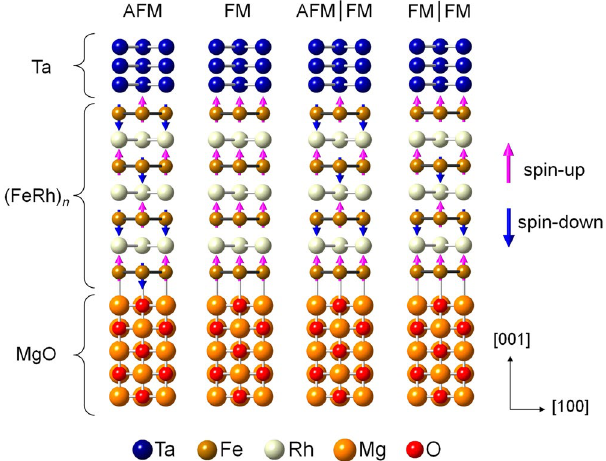
Figure 1. Representation of the atomic structure of Ta/FeRh/MgO multilayers for the different magnetic configurations: AFM-II, FM, AFM(I Ta )/FM(I O ), and FM(I Ta )/FM(I O ). The larger blue, brown, grey, orange, and smaller red spheres are Ta, Fe, Rh, Mg, and O atoms, respectively. The red upward and blue downward arrows indicate the spin orientations of Fe atoms. The letter n in the subscript denotes the number of FeRh unit cell